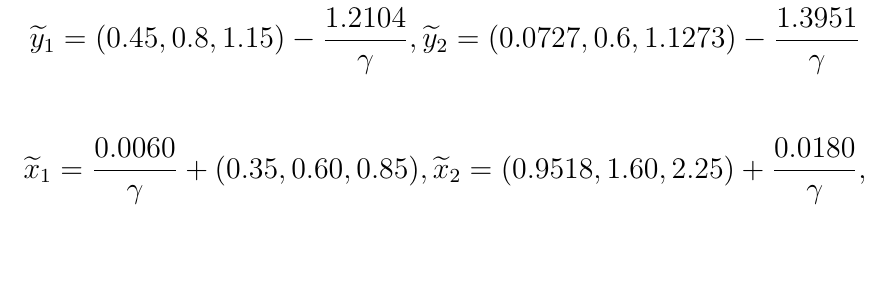
Solution : Figure 1: Finding an infeasible solution for primal fuzzy linear pro- gramming problem Using the fuzzy exponential barrier function algorithm we get, The fuzzy exponential barrier method is given